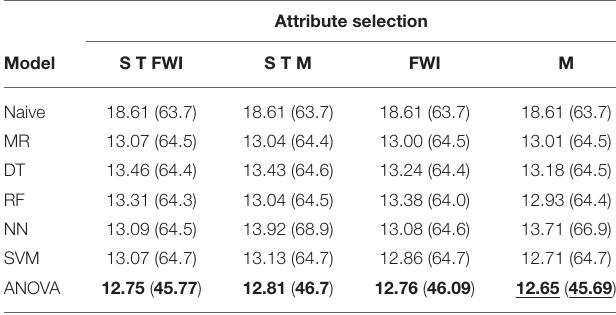
TABLE 3 | MAD and RMSE (in brackets) for the best performing model in the corresponding attribute subset (underline—overall best result, bold—best result for this selection).